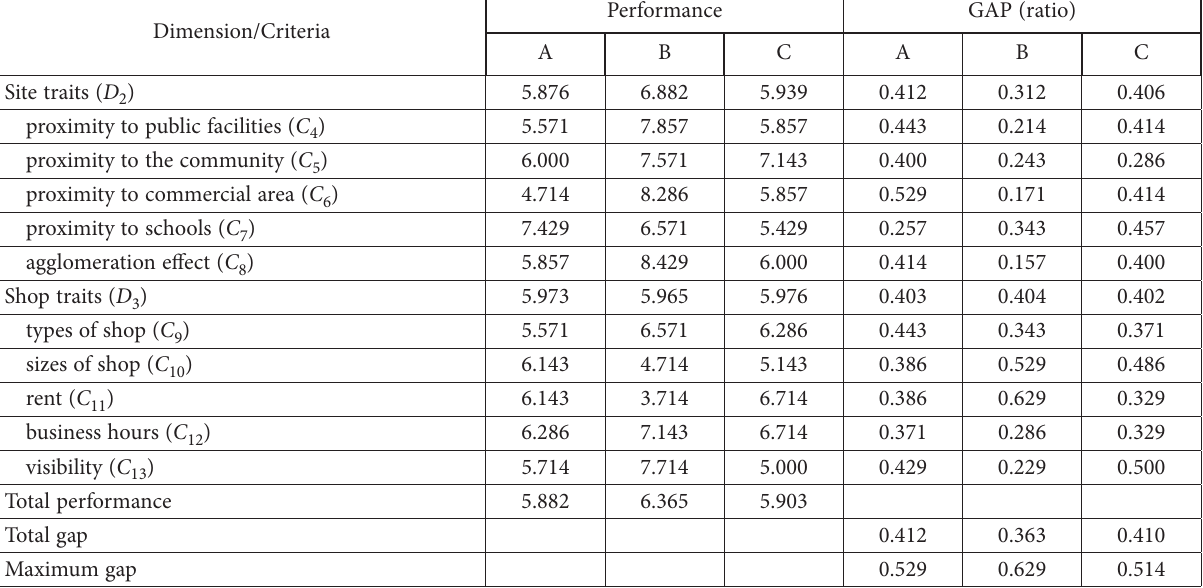
Table 11. Intergraded value R k under different decision-making parameters v